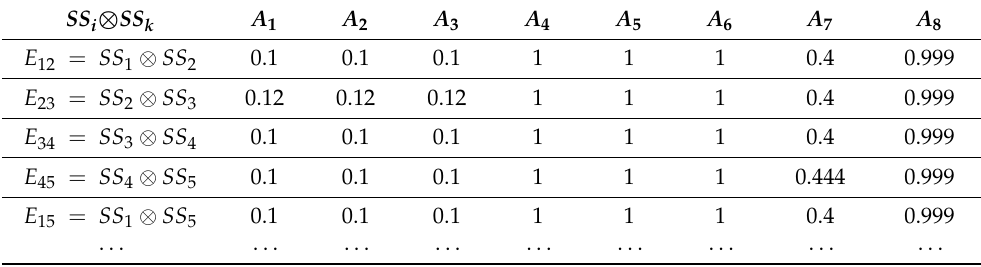
Figure 5. M-polar fuzzy graph at design of inverting summing amplifier. Table 2. Membership values of the edges.